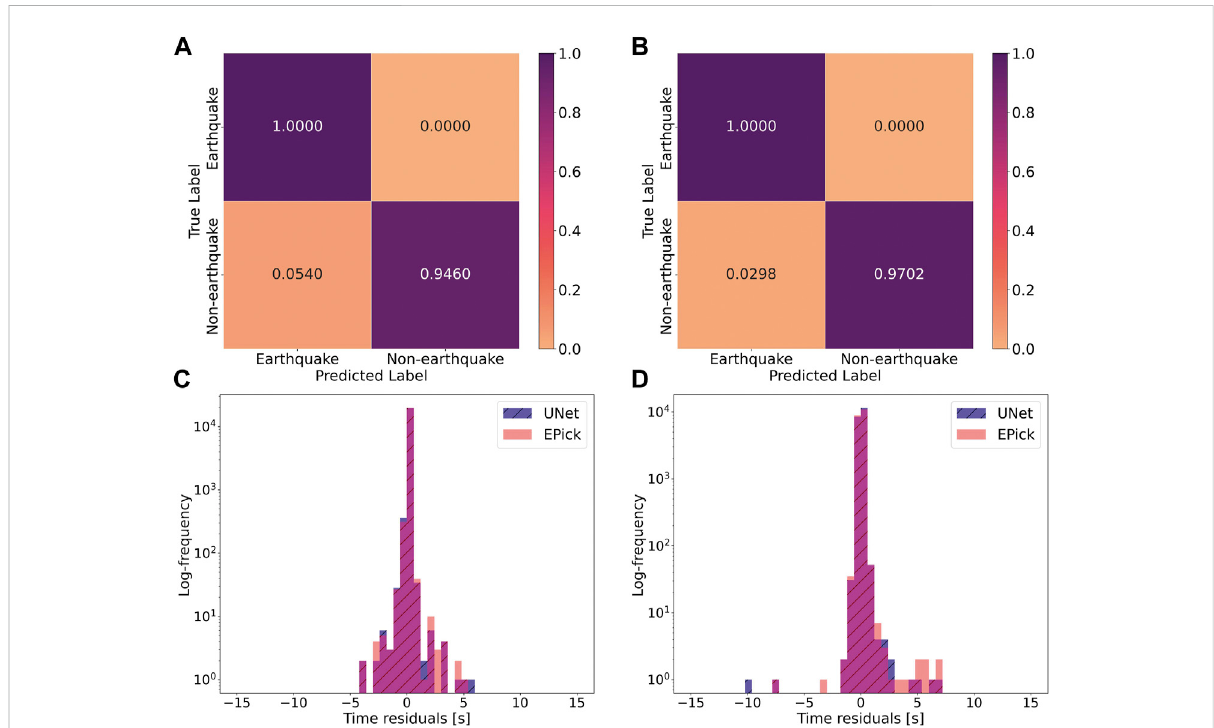
FIGURE 4 Result analysis for earthquake detection and phase arrival-time picking. (A,B) are confusion matrices for earthquake event detection in the testing data for UNet and EPick. During testing, EPick misclassi fi es less noise as earthquake events. (C,D) are the distributions of time residuals (also called time difference, Δ t ) for the fi rst P and S picks of UNet and EPick on the test data set. Here, the histogram color under the overlap area of two distributions is different from that of the legend in (C,D)